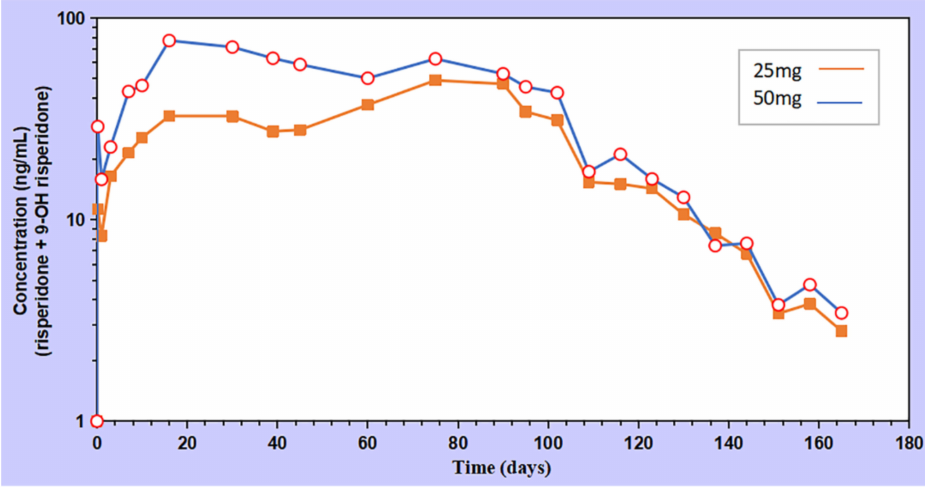
Figure 6. The pharmacokinetic curve of the implants.